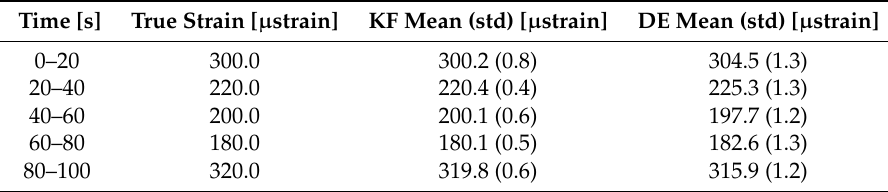
Table 2. Comparative performance of DE- and KF-based estimation for axial